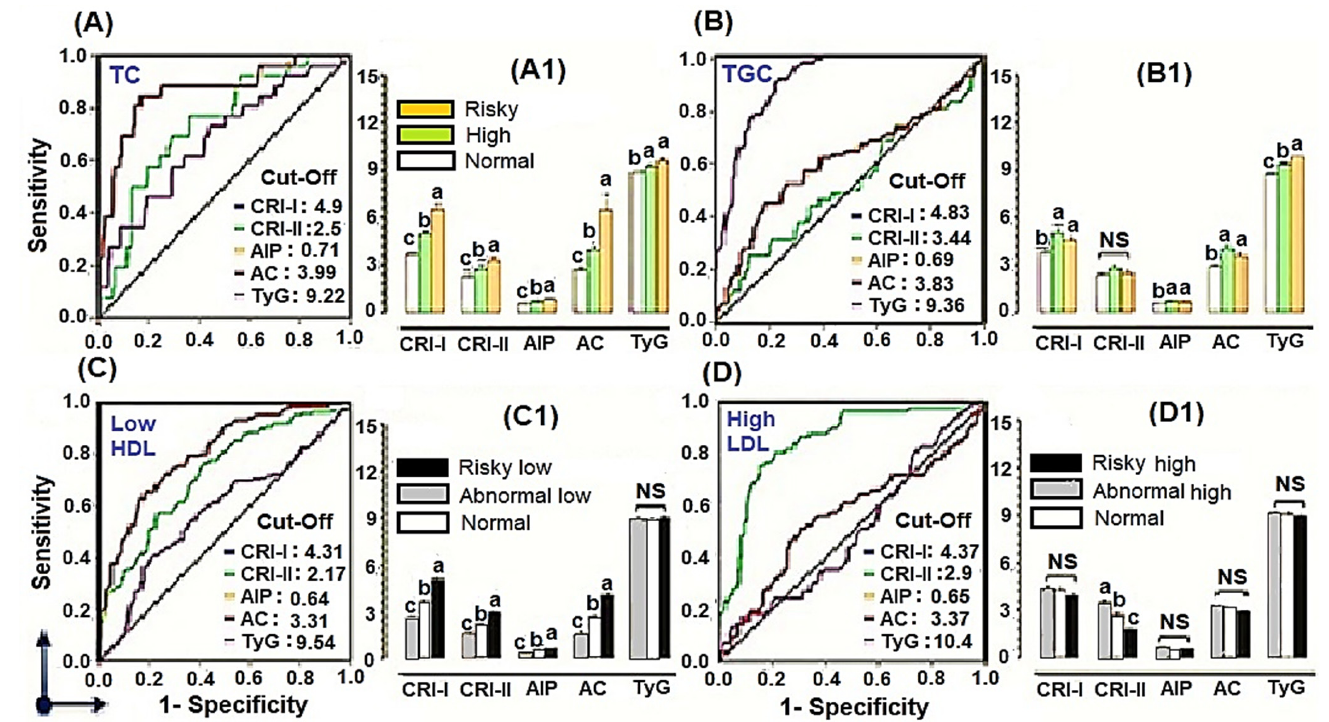
Figure 2. AUC–ROC curves of positive vs. negative incidence of CVDs in the dyslipidemic profiles via their sensitivities to the cardiometabolic risk factors and cut-off values ( A – D ). AUC–ROC above 0.6, 0.7, and 0.8 but not those less than 0.6 were considered for their cut-off values. Risk indices in normal vs. abnormal levels of the lipidemic profiles are shown in ( A1,B1,C1,D1 ). Differences between groups were considered significant at p < 0.05. NS: non-significant. Letters on bars; a, b, c, and d denote significant difference among groups.